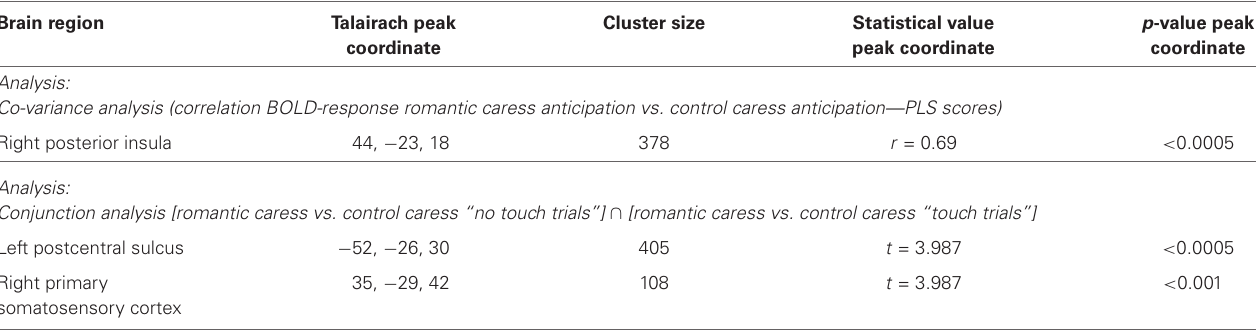
FIGURE 5 | Group statistical maps and graphs depicting differential BOLD-response for the romantic caress and control caress condition, both during caress anticipation and during caress performance, as